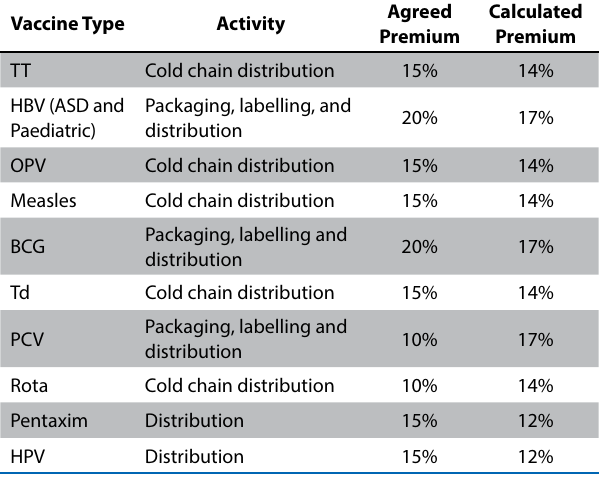
Table 5. Premiums charged and activity per